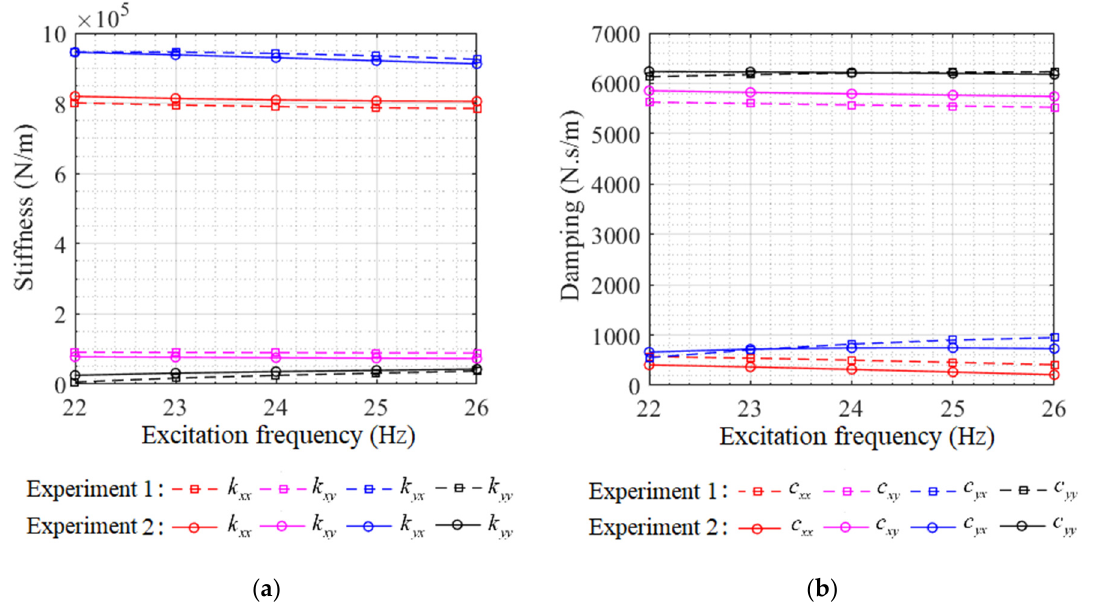
Figure 13. Comparisons of the dynamic parameters of Bearing 1 estimated in the two experiments. ( a ) Estimated stiffness coefficients of Bearing 1; ( b ) Estimated damping coefficients of Bearing 1. Table 5. Percentage deviations of the mean value of the estimates in the two experiments.